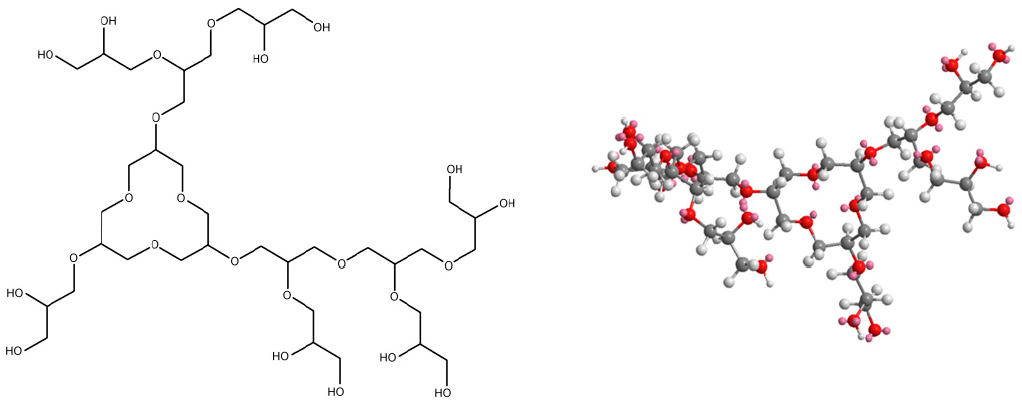
Figure 7. Structures of studied polymer—S XVI Mn = 3250, D = 1.21.